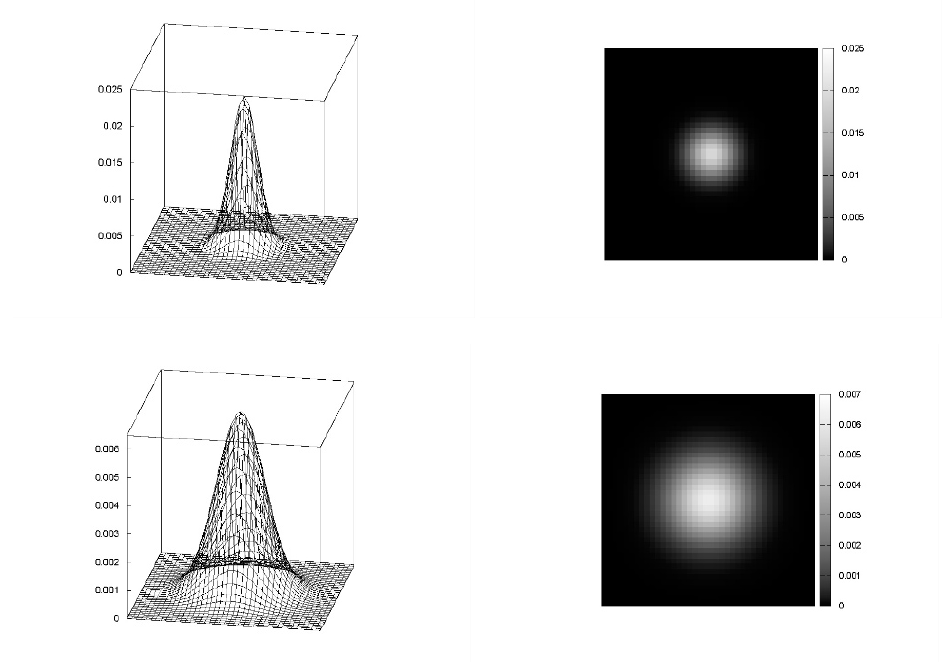
Figure 2. The wave function densities | z α | 2 and their contours with α = 1 above and α = 2 below for the interaction strength κ = 0